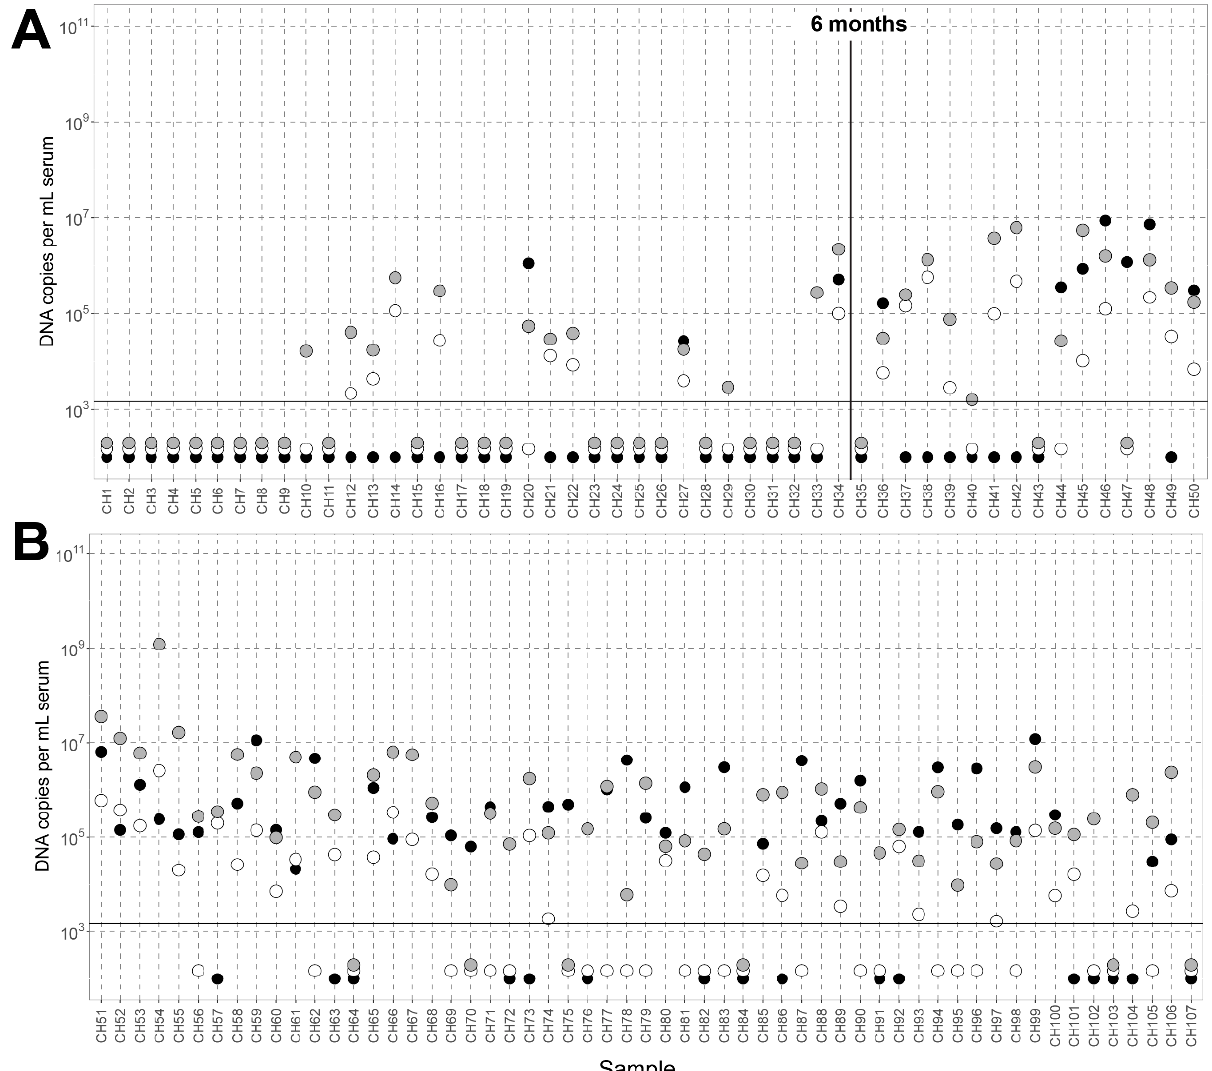
Figure 1. Anellovirus concentration in the children’s blood over months. ( A ) Anellovirus concentration in the first 12 months of life and ( B ) anellovirus concentration in children aged 12 months until 65 months. All samples are arranged in the order of children’s age and the age of 6 months is depicted with a vertical line. The samples under the horizontal line were either negative for the viruses, or samples contained concentrations below the cutoff. Filled black dots represent alphatorquevirus white dots betatorqueviruses, and gray dots gamma- or betatorqueviruses.